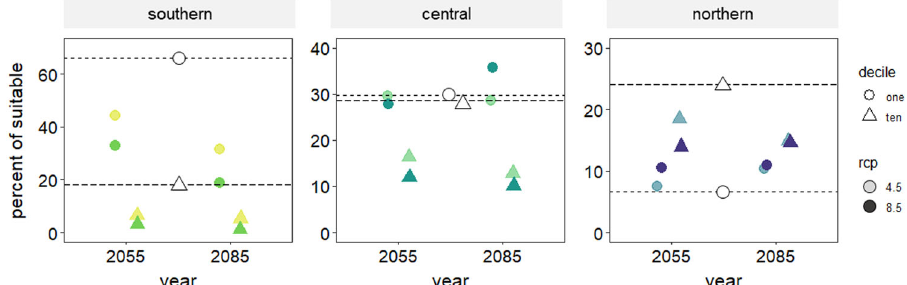
Fig. 4 Average projected change in frequency of the earliest 10% (decile one) and latest 10% (decile 10) of leaf out phenology across three genetic provenances of P. angustifolia relative to the total landscape with at least a richness value of 1 (i.e., excluding unsuitable area) across genetic provenances. Empty symbols and dotted lines represent climate norms or starting conditions and fi lled symbols represent frequencies at each time averaged across AOGCMs. Circles represent decile 1 and triangles represent decile 10. Lighter shades represent RCP 4.5 and darker shades represent RCP